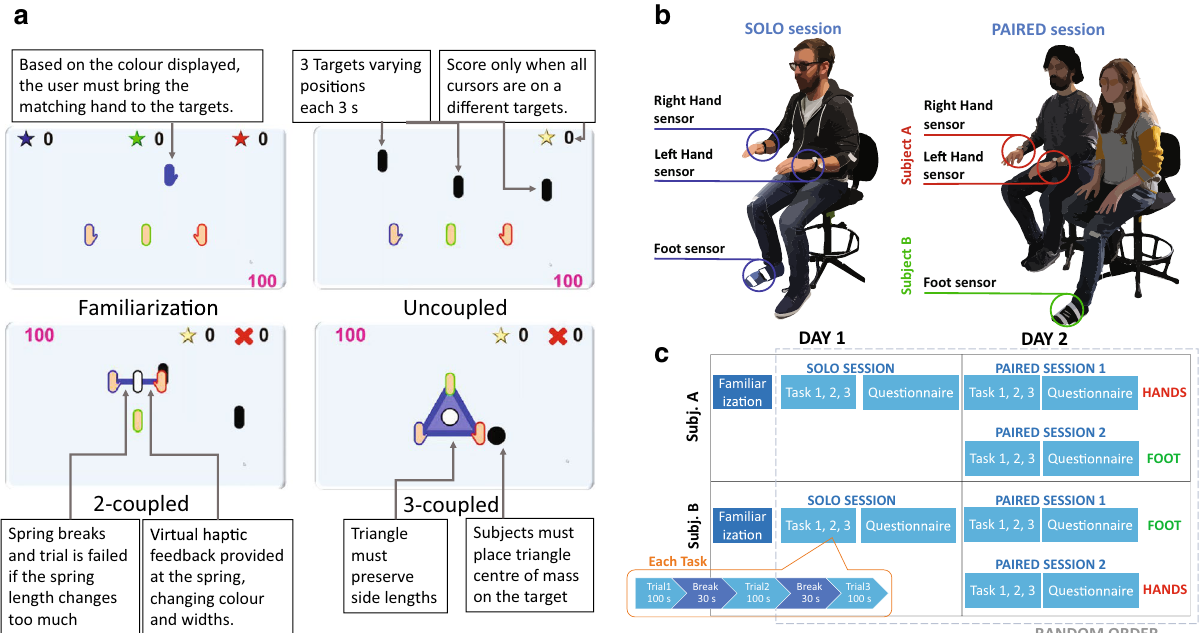
Figure 2. ( a ) Virtual tasks: Familiarization: one target appears at a time, with the same colour and shape of the tracking limb; Uncoupled Task: three black targets appear, each cursor has to reach a different target; 2-coupled Task: the two hands are virtually coupled by means of virtual spring. Two targets appear and have to be tracked with the foot and spring center of mass, while the spring length must be maintained. 3-coupled Task: One black target appear at a time. This must be tracked with the center of mass of the three coupled limbs without overstretching/over-compressing. ( b ) Participants performing the solo and paired sessions. ( c ) Experimental protocol: Each subject (Subj. A and Subj. B) performed three sessions across 2 days. Familiarization was always first, then the Solo and Paired session order was randomised. Each session considered each task, first the uncoupled and then the other two randomly arranged. Each task was repeated three